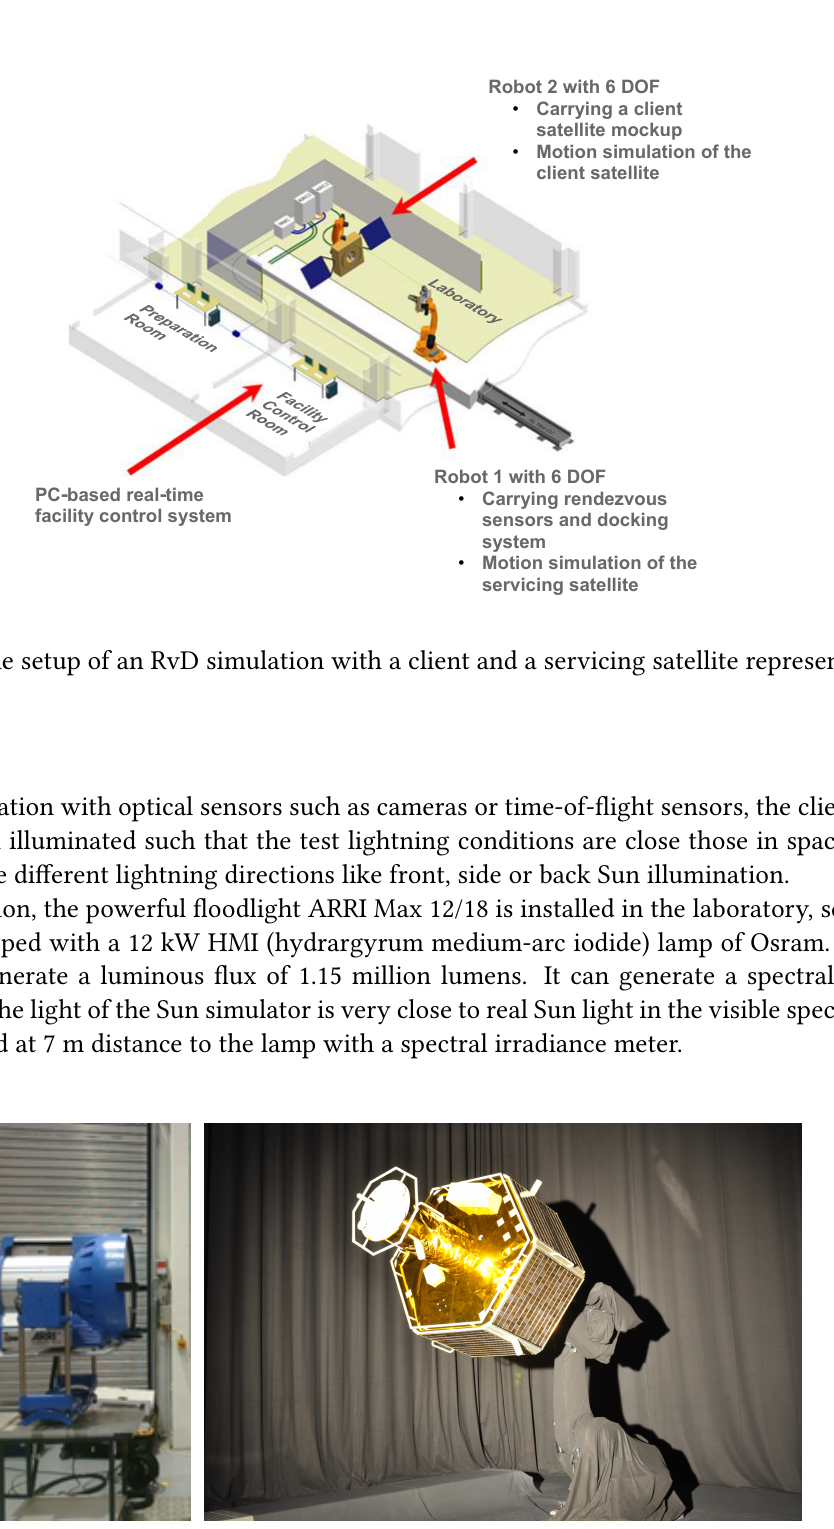
Figure 4: Sun Simulation. Left: spotlight ARRI Max 12/18 with a 12 kW HMI lamp. Right: robot with illuminated client